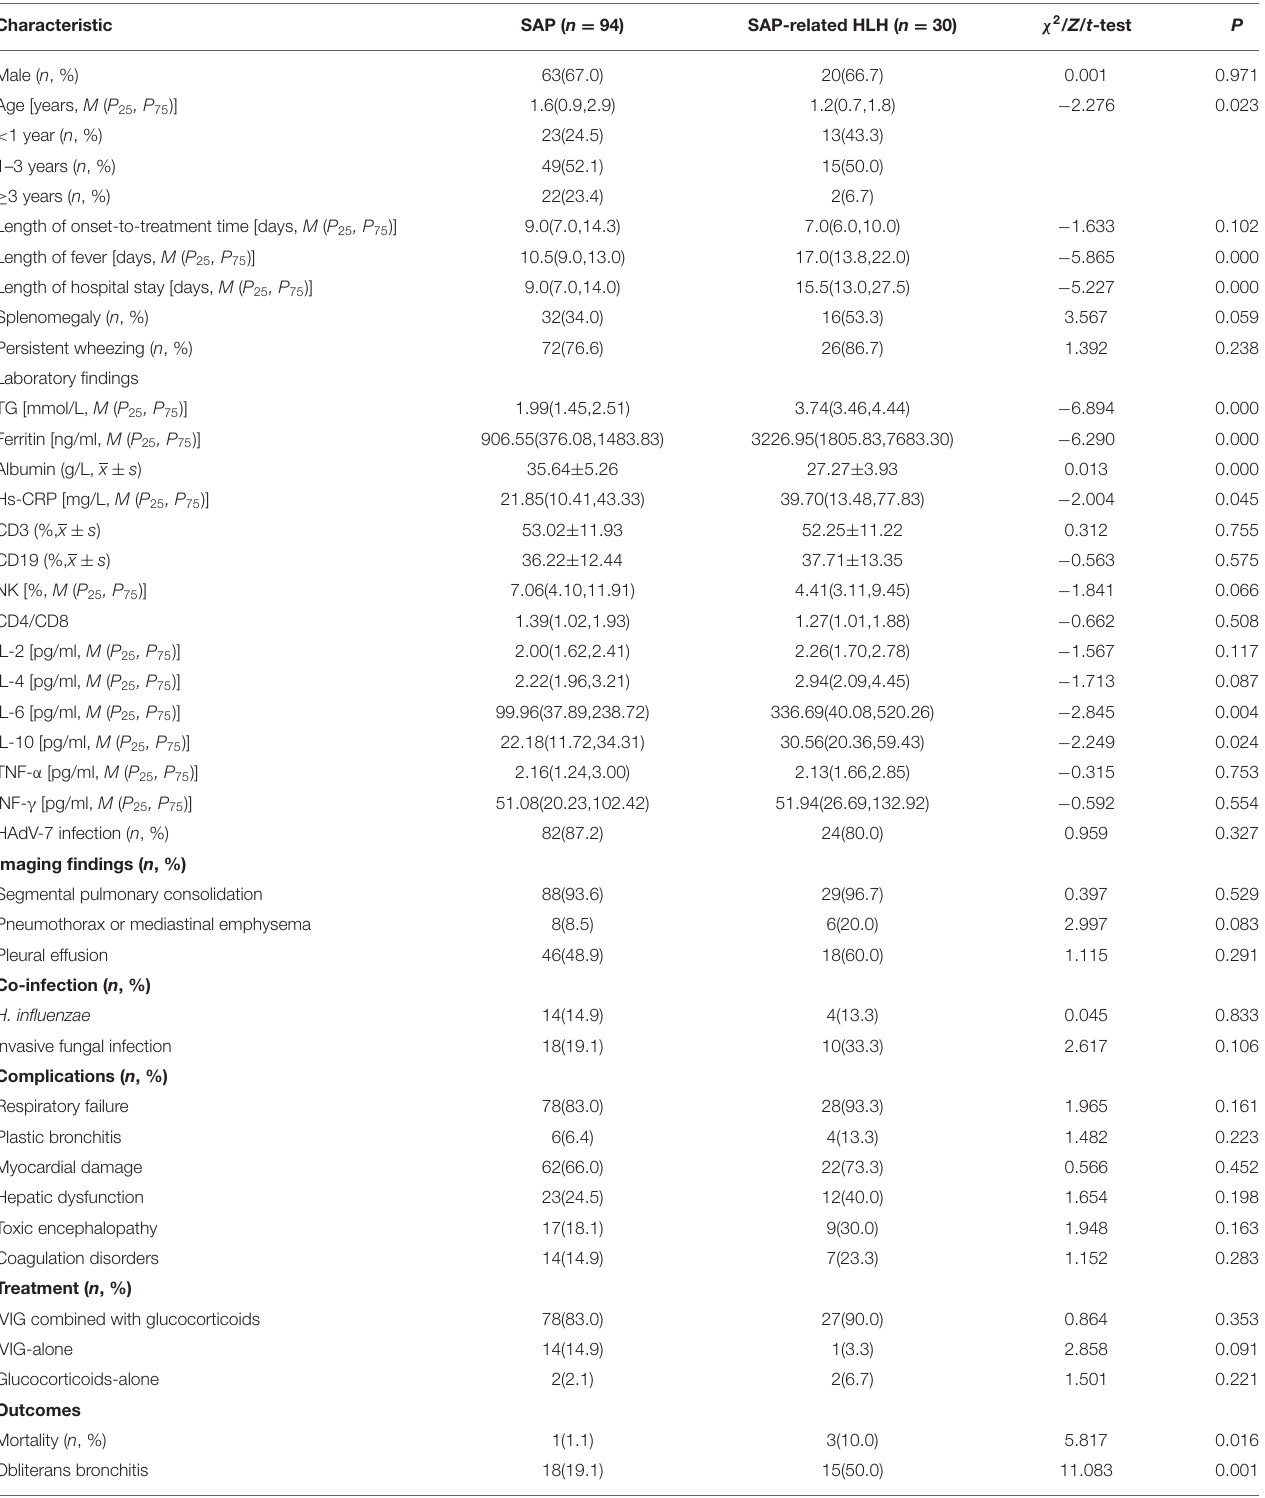
TABLE 1 | Clinical characteristics of the patients included in this study.